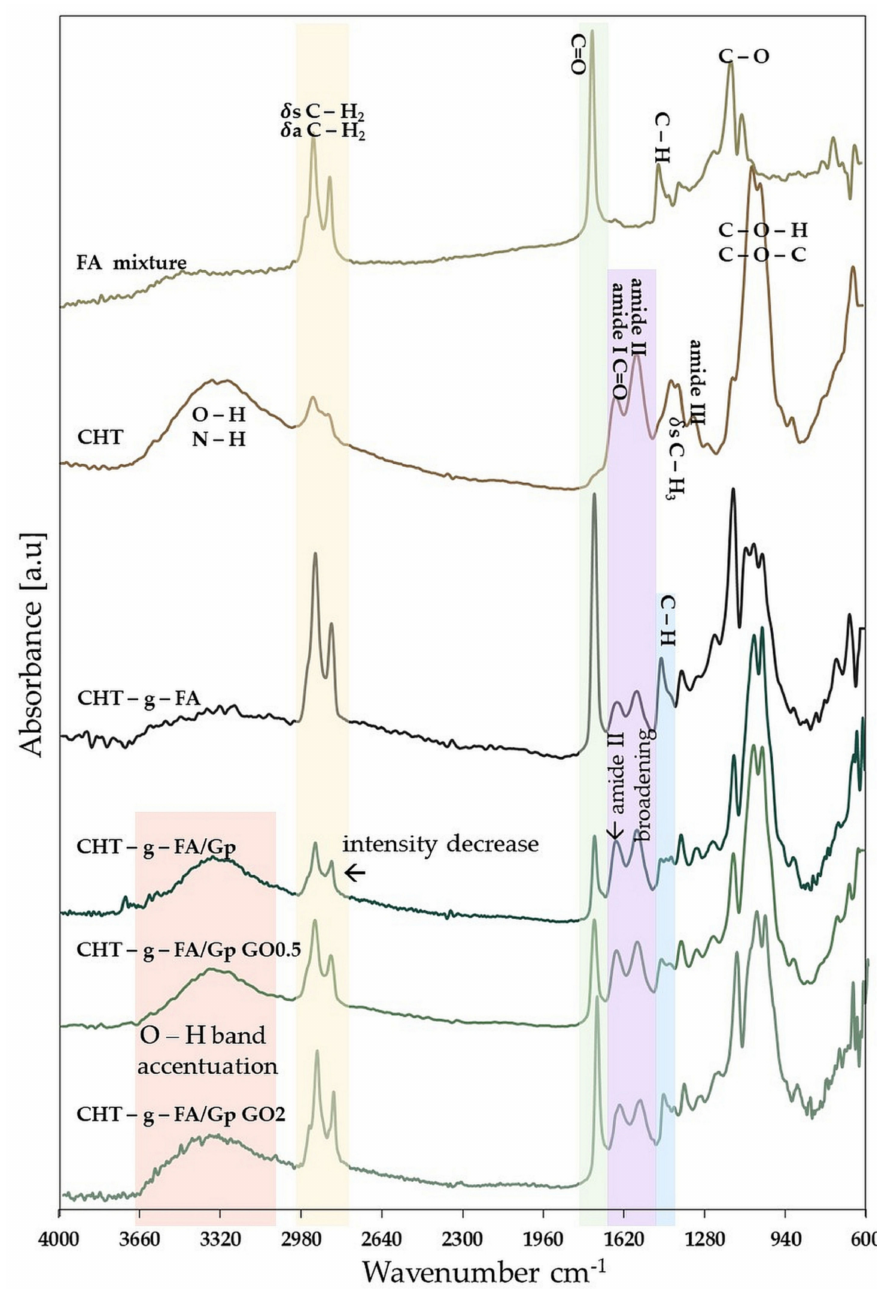
Figure 1. FTIR spectra of precursors and CHT-g-FA copolymers and